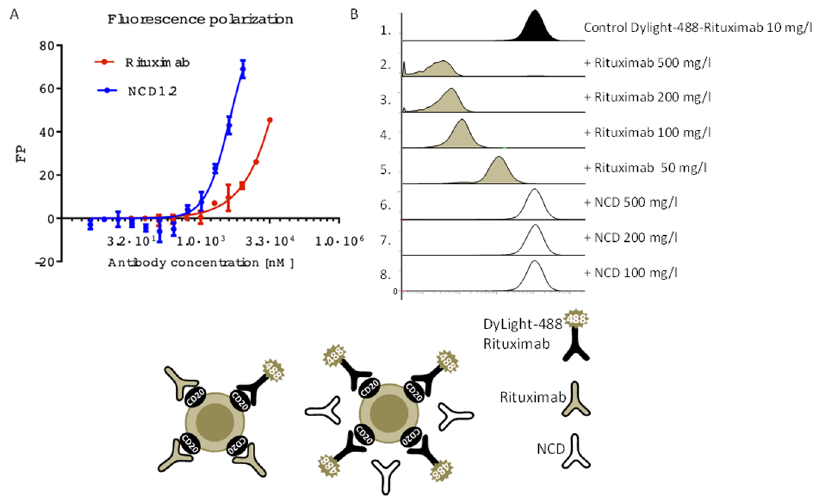
Fig 3. Comparison of NCD1.2 and Rituximab. (A). NCD1.2 and Rituximab were titrated into reactions containing fixed amounts of fluorescent human CD20 peptide (FITC; 30 nm peptide) and relative binding affinities were compared to each other in order to determine how the epitopes for the two monoclonal antibodies might differ. The data are plotted as changes in polarization as a function of increasing antibody concentration. (B). The human SUDHL4 B-cell lymphoma cell line expressing CD20 was incubated with Rituximab conjugated by DyLight 488 (10 μ g/ml). The non-labeled Rituximab was added in increasing concentrations to samples 2 – 5. The non-labeled monoclonal antibody NCD1.2 was added to samples 6 – 8. The intensity of Rituximab-DyLight 488 was measured using flow cytometry.